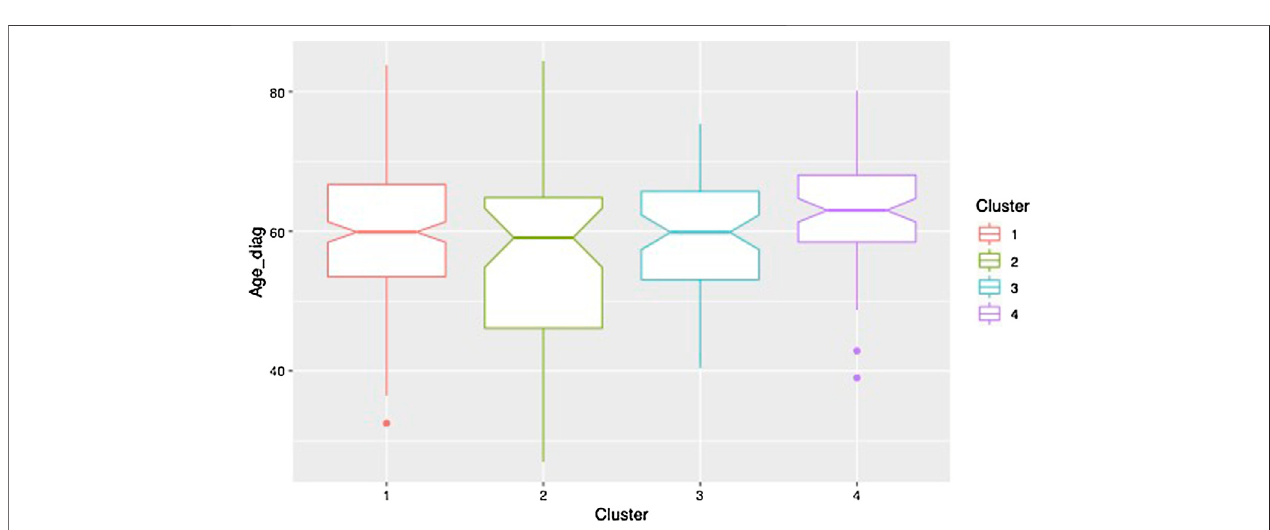
FIGURE 6 | Boxplot of the age at diagnosis for each of the